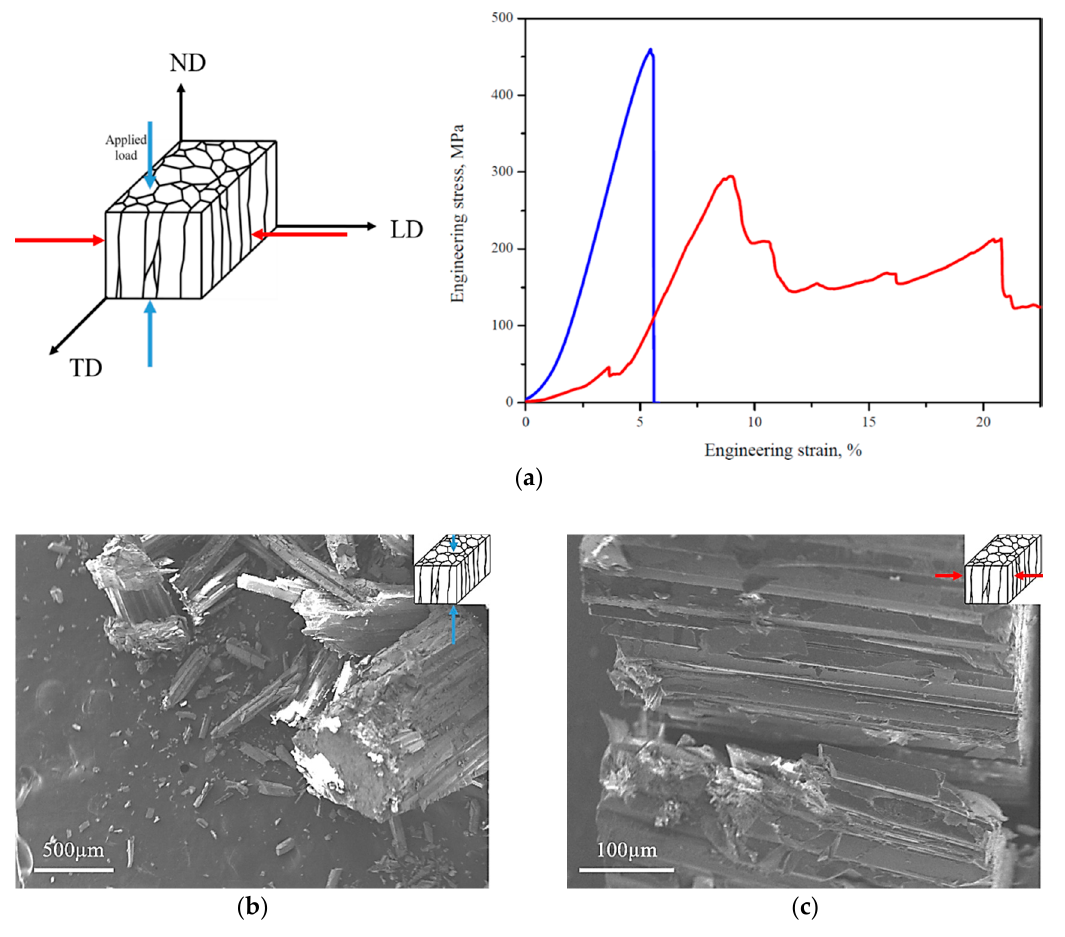
Figure 4. Representative stress-strain curves obtained in the static compression test for P. margaritifera performed along ND and LD ( a ) and SEM/SE images of the samples after static compression test for loads applied along ND ( b ) and LD ( c ).